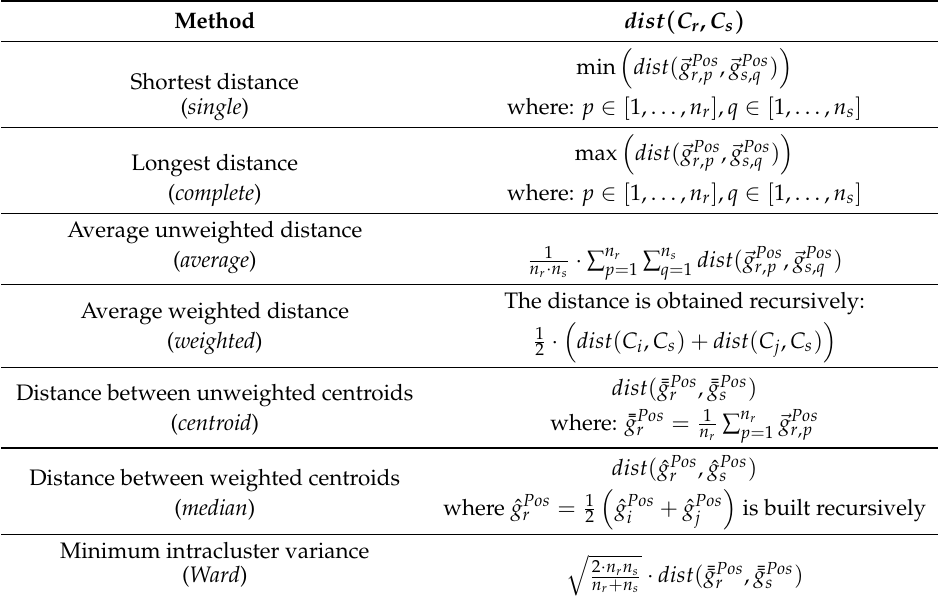
Table 1. Methods to calculate the distance between two clusters in the hierarchical clustering